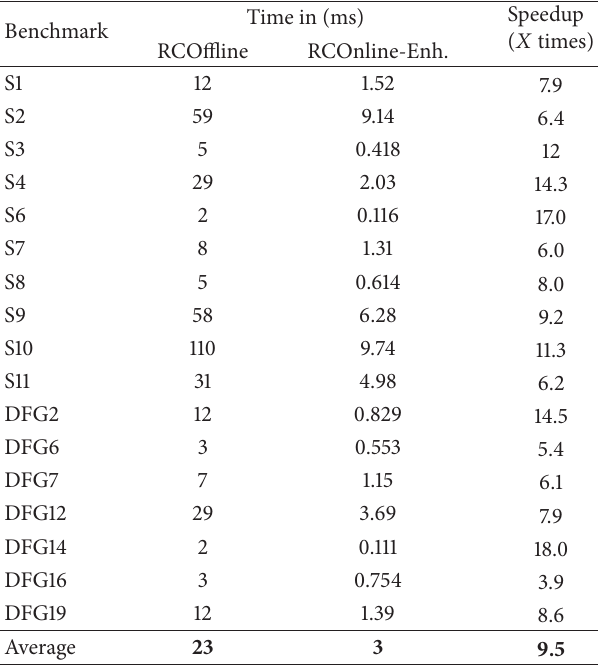
Table6:Comparisonofschedulersbasedonnumberofreusedtasks (after